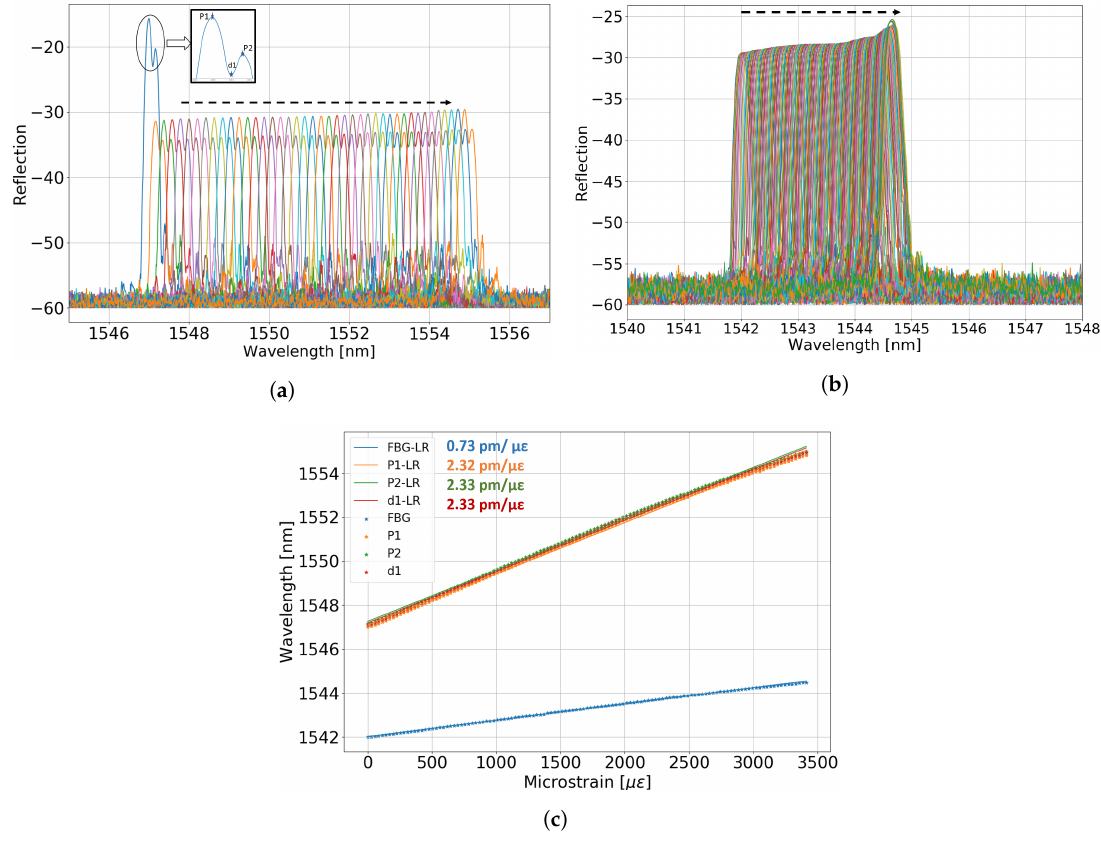
Figure 12. Spectral response of both sensors: ( a ) FP sensor; ( b ) FBG sensor; and ( c ) wavelengths recovered from spectrum. Table 3. Linear Regression of Sensor Wavelength Tracked from Spectrum (Figure